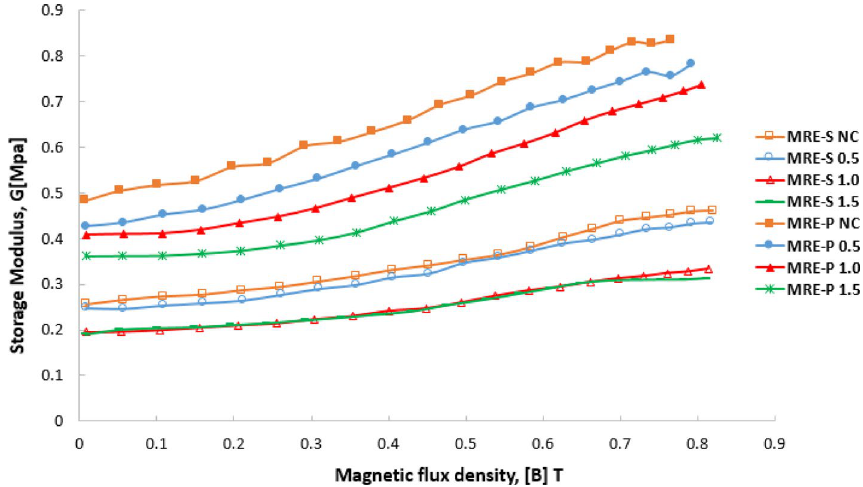
Figure 13. Change of stiffness or storage modulus corresponding to various magnetic flux densities, B for MRE samples containing different corrosion conditions of spherical and plate-like CIPs.